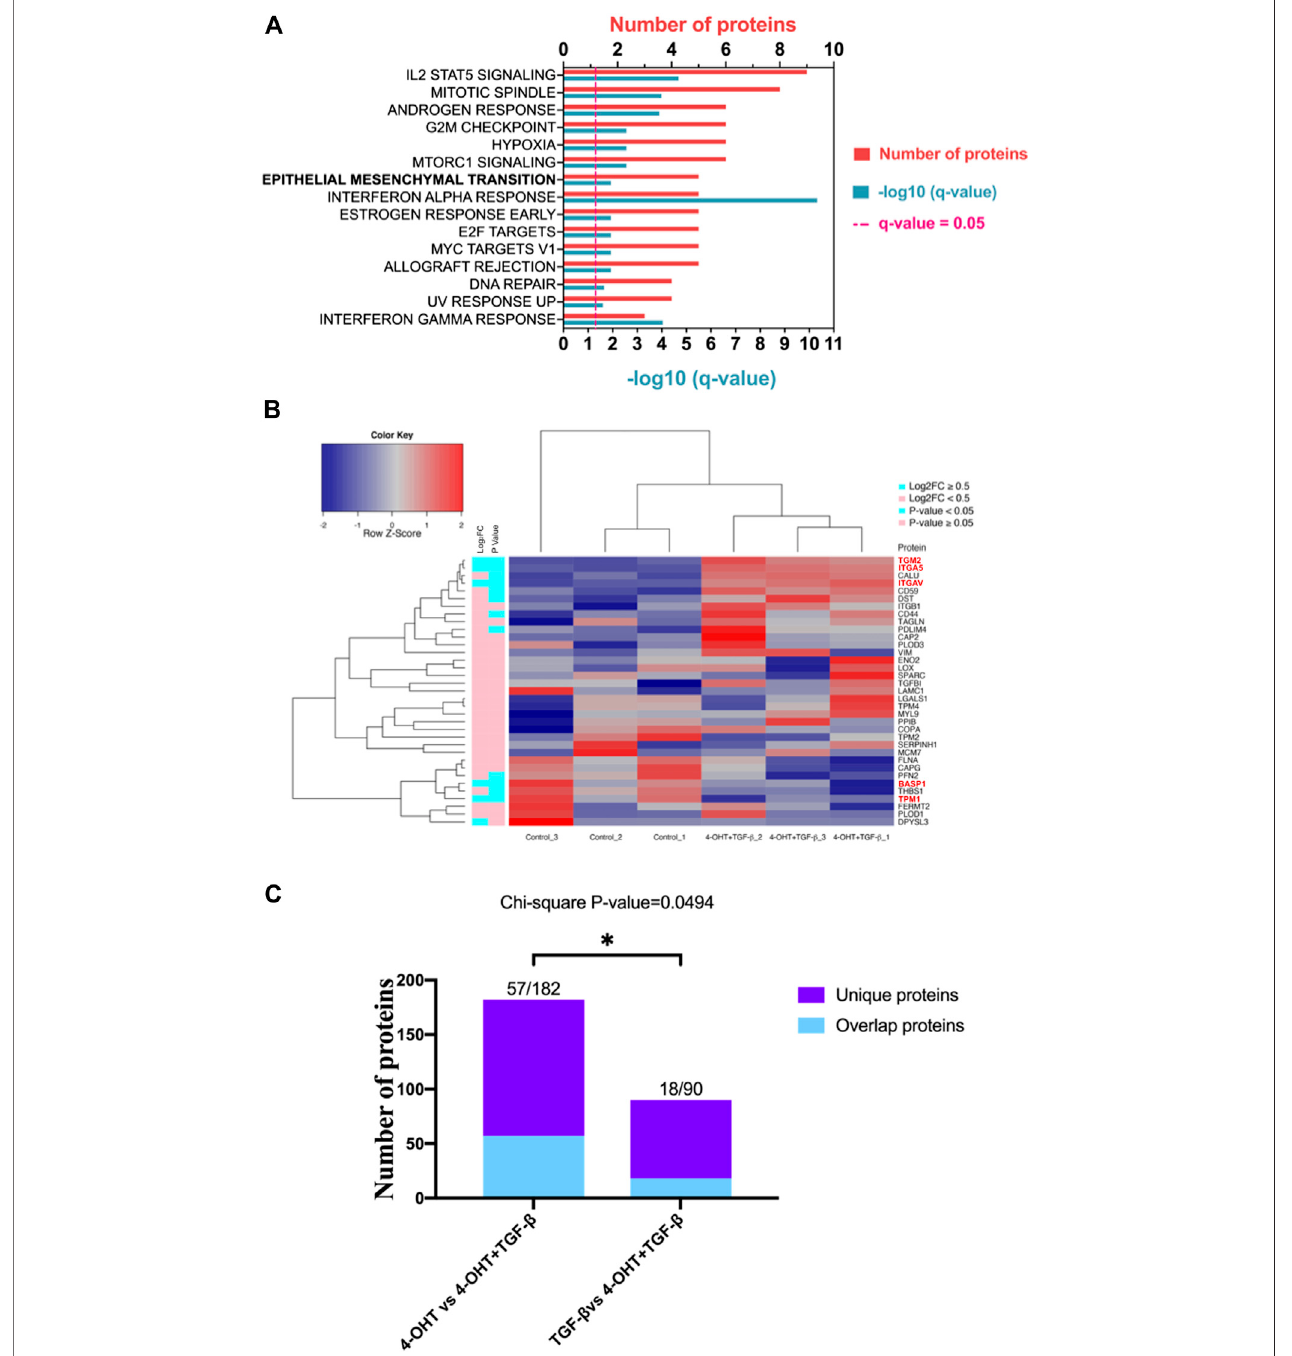
FIGURE3| RAS-activationtogetherwithTGF- β arecapableofinducingEMTandRASsignalingappearstodriveEMT. (A) PathwayanalysisinMetascape(Metascape.com) analyzing differentially expressed proteins (DEPs) in ATII ER:KRASV12 cells treated with a combined treatment of 250 nM 4-OHT and 5 ng/ml TGF- β or control for 24 h, all non- signi fi cantpathwayshavebeen removedfrom thediagram. (B) Heatmap and hierarchicalcluster analysisofATII ER:KRASV12 cells treatedwithacombinedtreatmentof250 nM 4- OHTand5 ng/mlTGF- β orcontrolfor24 h,apanelofhallmarkEMTproteinswereevaluated. p Value(blue: p Value < 0.05,pink: p Value ≥ 0.05).Absolutelog 2 foldchange (blue: | log 2 FC | ≥ 0.5, pink: | log 2 FC | < 0.5). Red text indicates differentially expressed proteins (DEPs). (C) Diverging bar chart indicating the number of uniquely differentially expressed proteins in indicated treatments (Chi-squared test, p Value (cid:2) 0.0494).